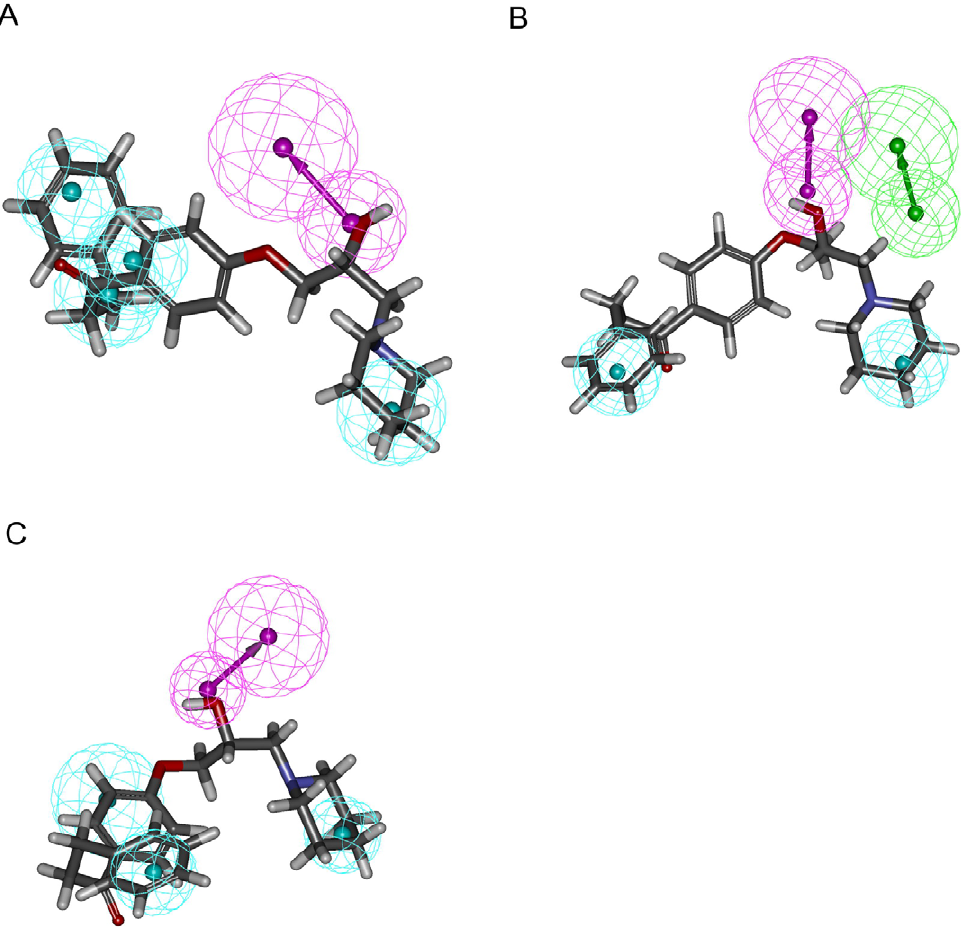
Figure 9. Superposition of pharmacophore models and 13. Pharmacophore models (A) Hypo A, (B) Hypo B and (C) Hypo C fitted to 13 . The chemical features are described in Figure 2.